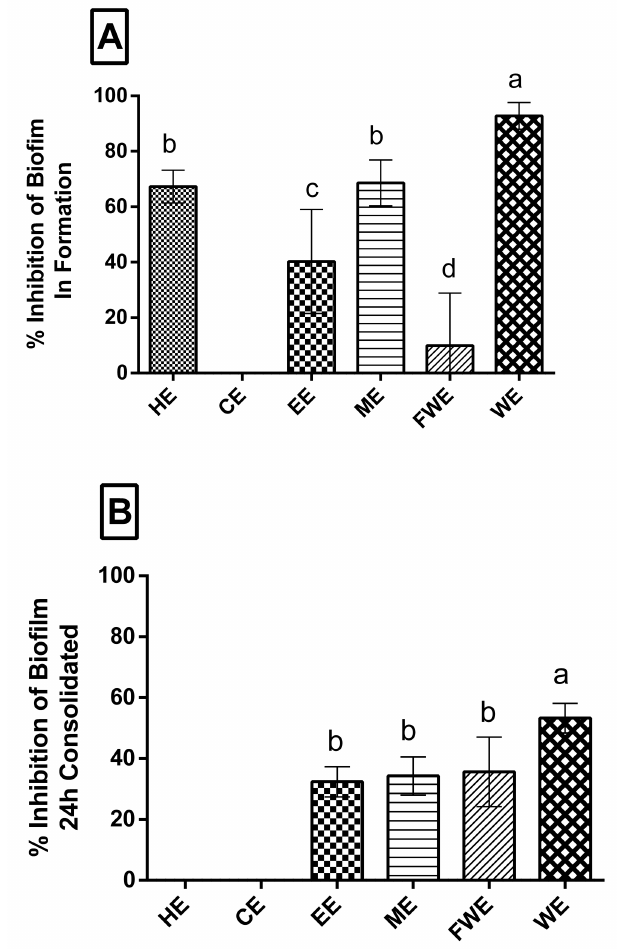
Figure 2. Percentage of biofilm inhibition. Graphs showing the results of the e ff ects of M. zehntneri extracts on biofilm formation ( A ) and consolidation ( B ) of S. epidermidis , where 100% is the maximum inhibition shown by gentamicin, a positive control. The x-axis represents the extracts and the y-axis represents percentage of biofilm inhibition. This assay was performed in triplicate. HE, hexane extract; CE, chloroform extract; EE, ethanol extract; ME, methanol extract; FWE, final water extract; WE, water extract. Data were analyzed by ANOVA-Tukey test, p < 0.001. Di ff erent letters (a, b, c, d) correspond to the significant di ff erences in statically